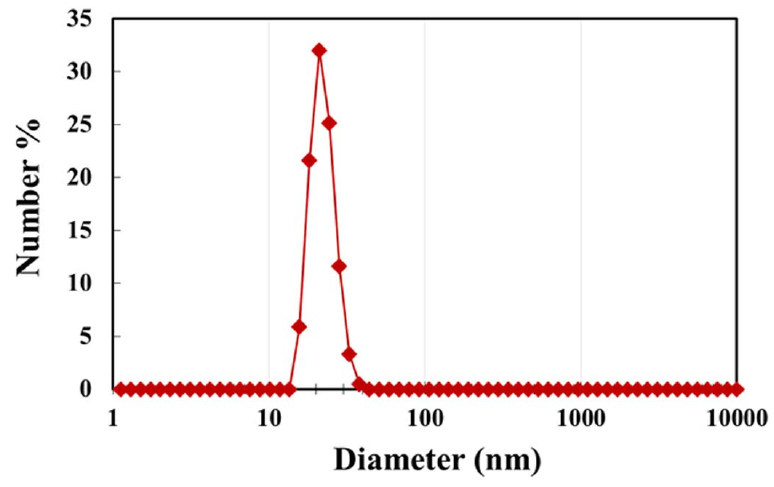
Figure 2. Size distribution of starch nanoparticles [34].